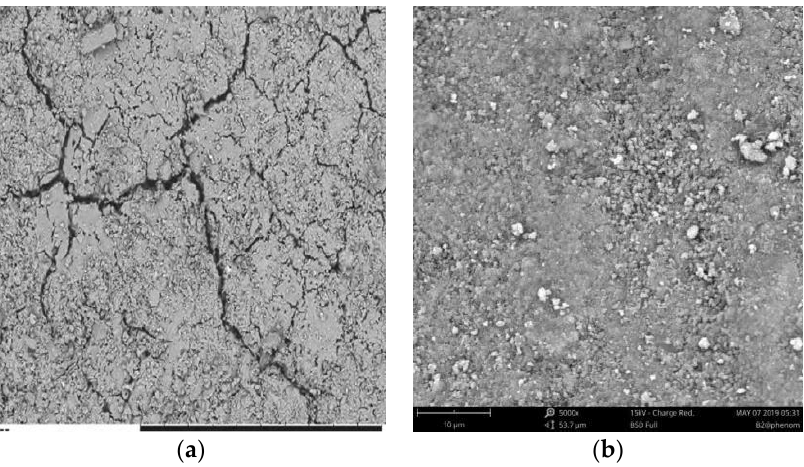
Figure 5. SEM photos of specimens: ( a ) slag content is 0%; ( b ) slag content is 10% [28].